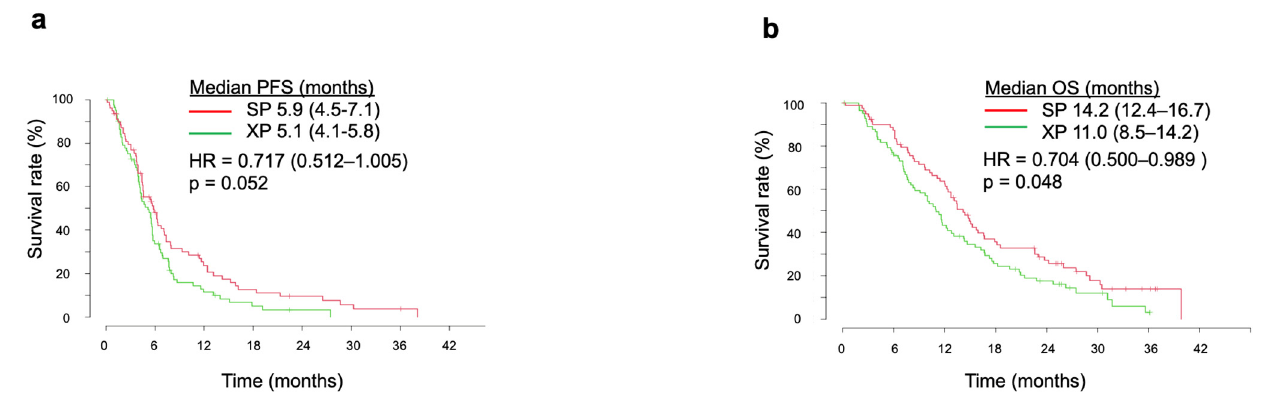
Figure 1. Kaplan–Meier analysis of PFS ( a ), and OS ( b ) in the SP and XP arms in the integrated analysis. The p values were determined with the log-rank test.